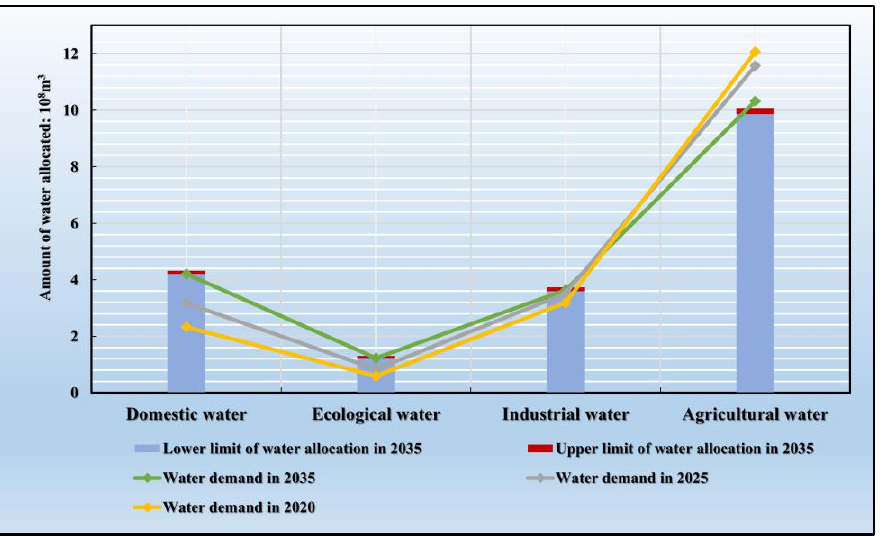
Figure 5. Water demand and water resource allocation in Binzhou in 2035.